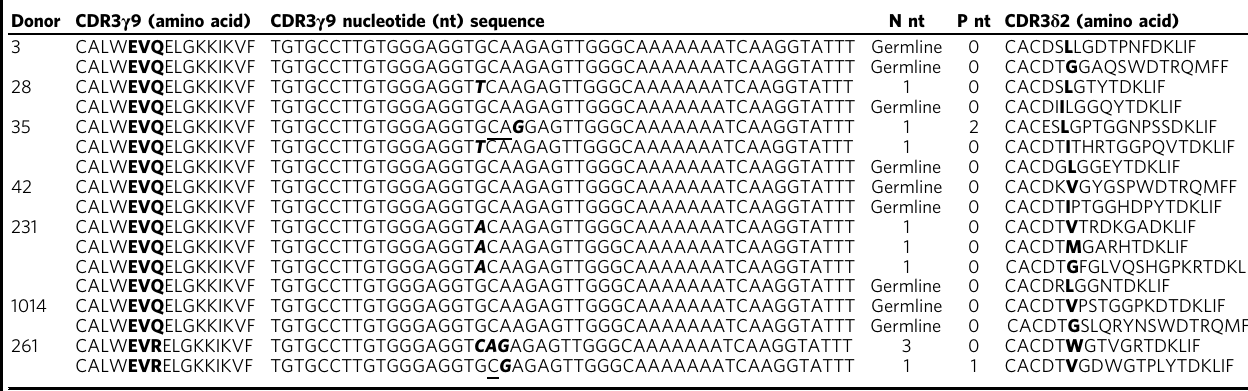
Table 1 Single-cell TCR sequencing of adult V γ 9 + V δ 2 + T cells Donor CDR3 γ 9 (amino acid) CDR3 γ 9 nucleotide (nt)